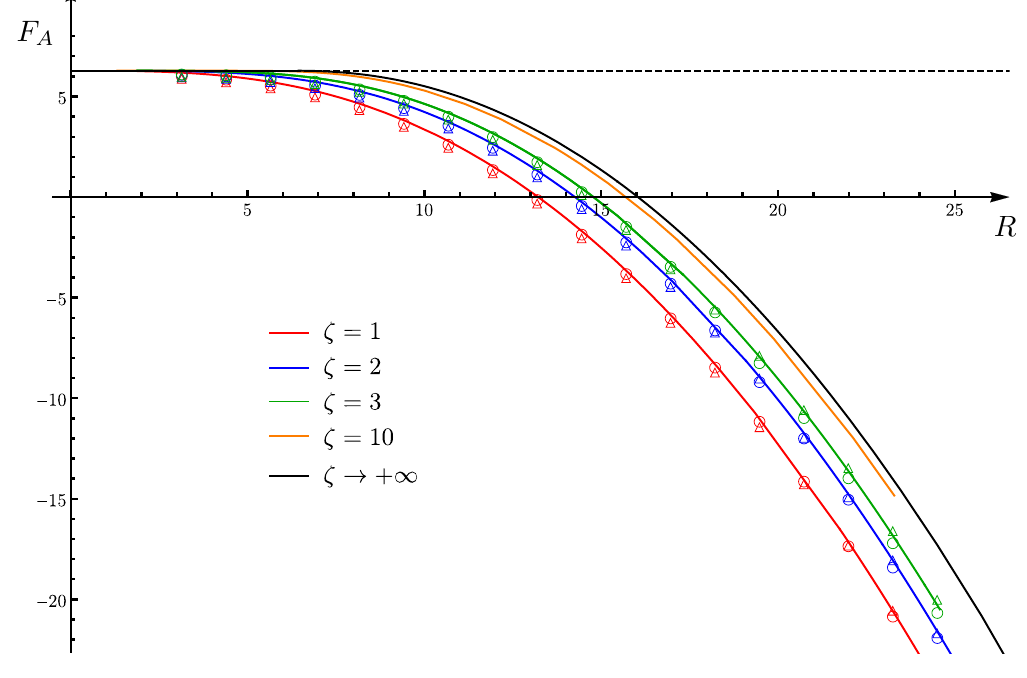
Figure 4 . Finite term F A for minimal surfaces anchored to a disk of radius R when the bulk metric is the black hole (2.29), with d (cid:18) = 2, di(cid:11)erent values of (cid:16) and the horizon set to z h = 1. The solid black curve corresponds to the analytic solution (5.28) described in section 5.2.3, while the remaining coloured solid lines have been obtained by evaluating (5.23) on the minimal surface whose radial pro(cid:12)le has been found by solving numerically the equation of motion of (5.21). The data points labelled by the empty circles and the empty triangles have been obtained with Surface Evolver through the two formulas in (5.20) respectively. The horizontal black dashed line corresponds to F A = 2 (cid:25) , that gives the (cid:12)nite term of the holographic entanglement entropy of disks when the gravitational background is AdS 4